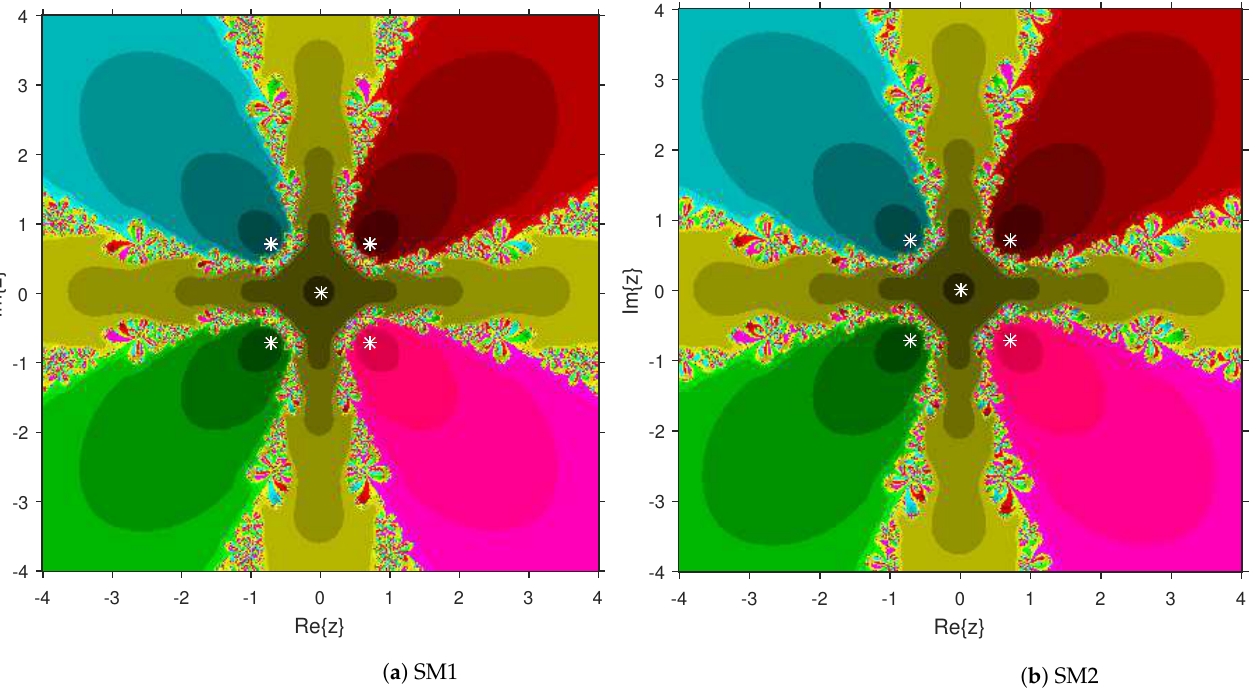
Figure 8. Attraction basins comparison between SM1 and SM2 corresponding to M 8 ( z )